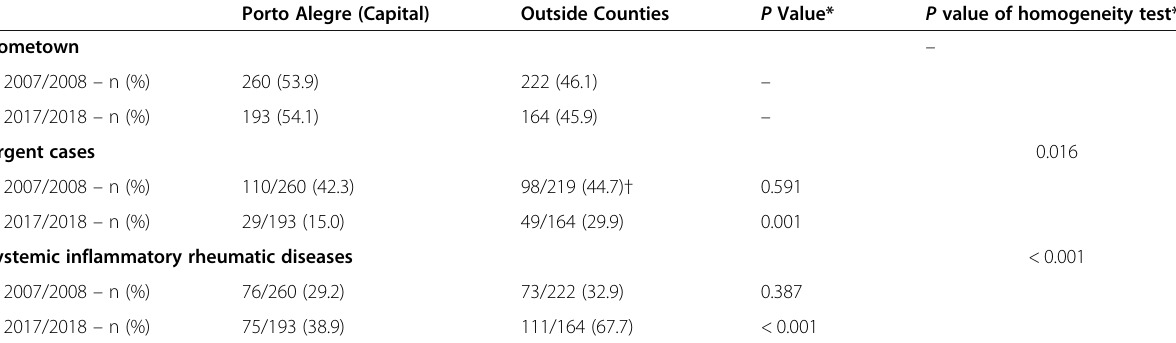
Table 5 Comparison of features of patients referred to first Rheumatology consultations in 2007/2008 (482 patients) and 2017/2018 (357